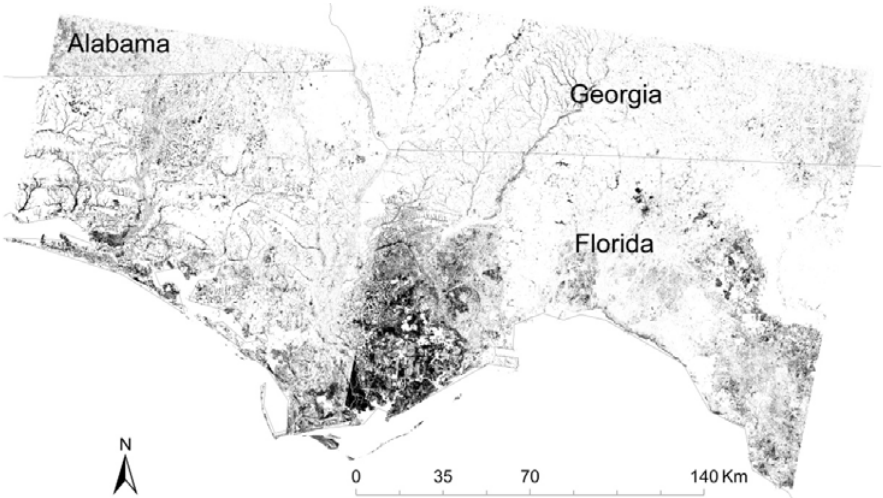
Figure 3. Cypress distribution in the Florida